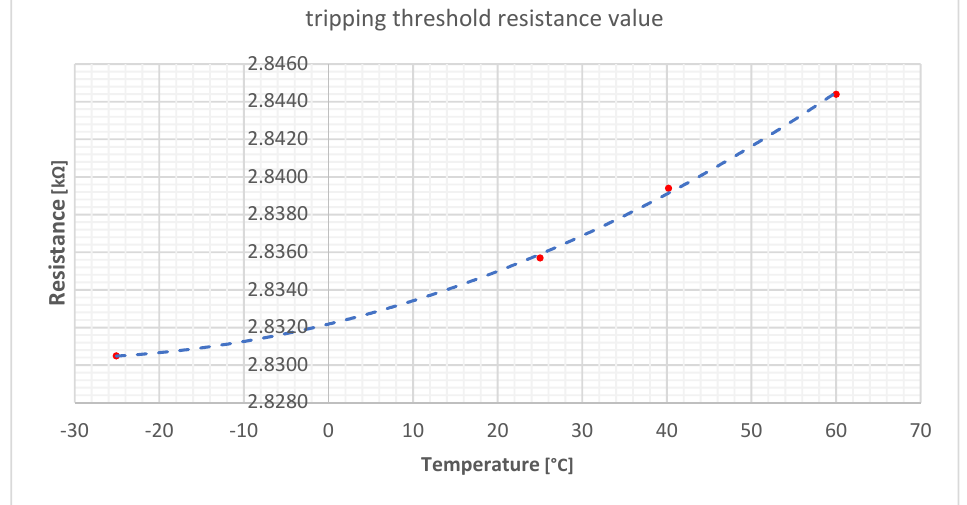
Figure 7. Impact of temperature of a parametric IDS circuit upper tripping threshold resistance value. Figure: Impact of temperature on the IDS detection circuit lower tripping